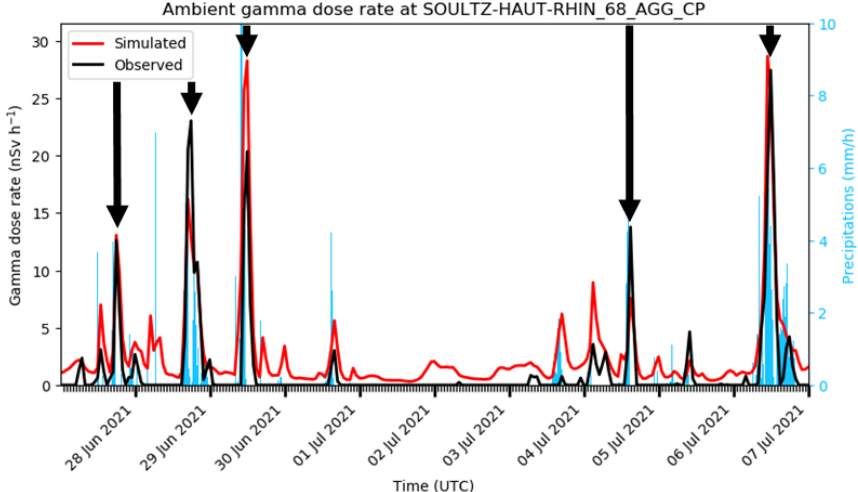
Figure 6. Five TP in a row, at the Soultz–Haut–Rhin station at the start of summer 2021. TP are marked with black arrows.